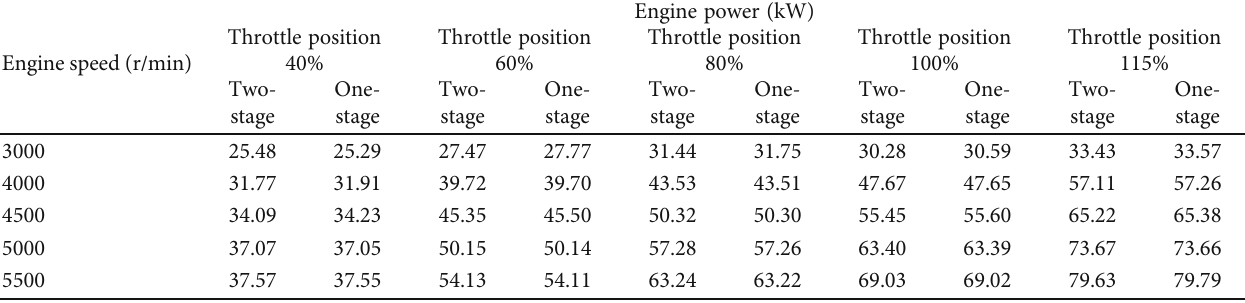
Figure 3: Schematic diagram of the two-stage turbocharging system. Table 1: Comparison of engine power when using di ff erent turbochargers.